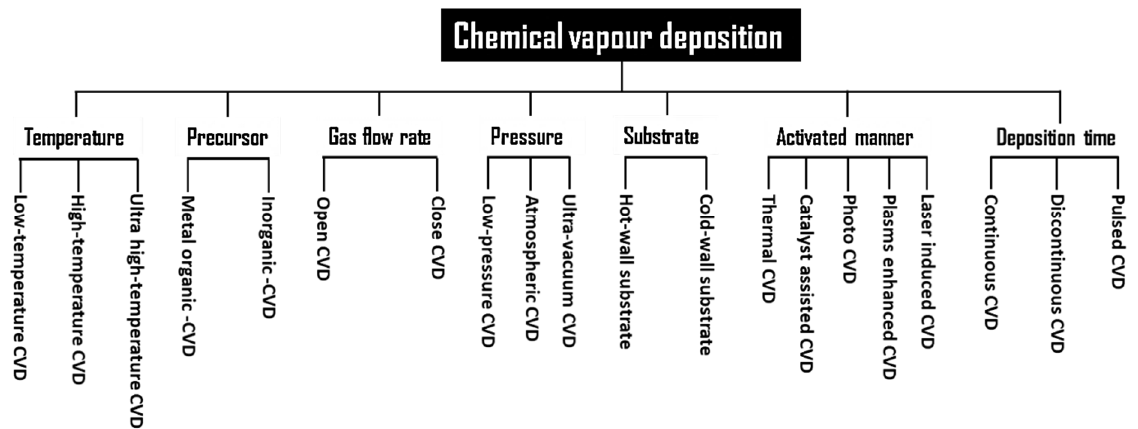
Figure 14. Classification of CVD methods. Reproduced with permission from [96].